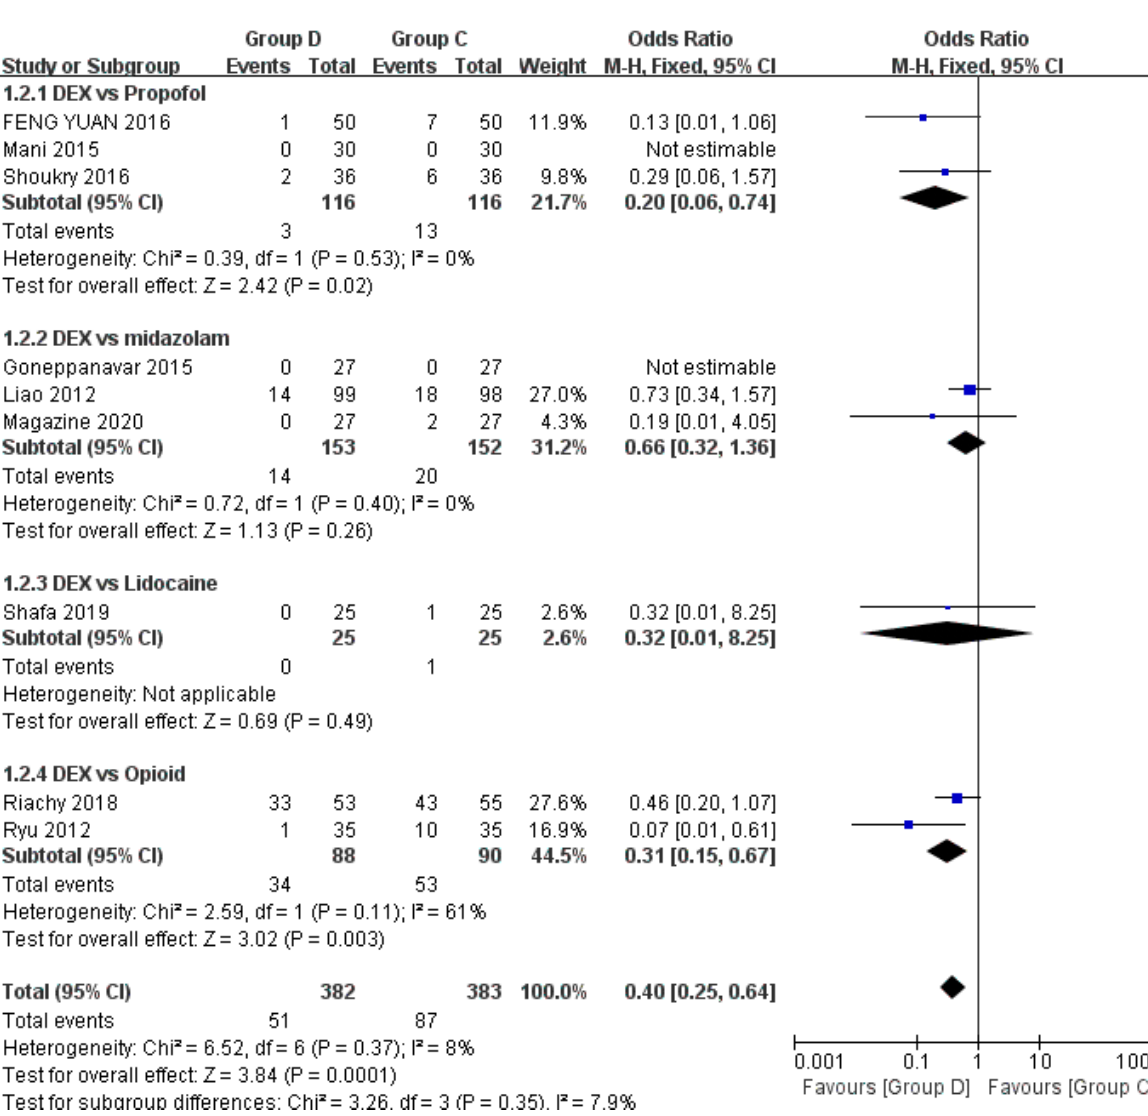
Figure 3. Forest plots comparing the effects of dexmedetomidine and control group on hypoxemia [22–24,27–32].